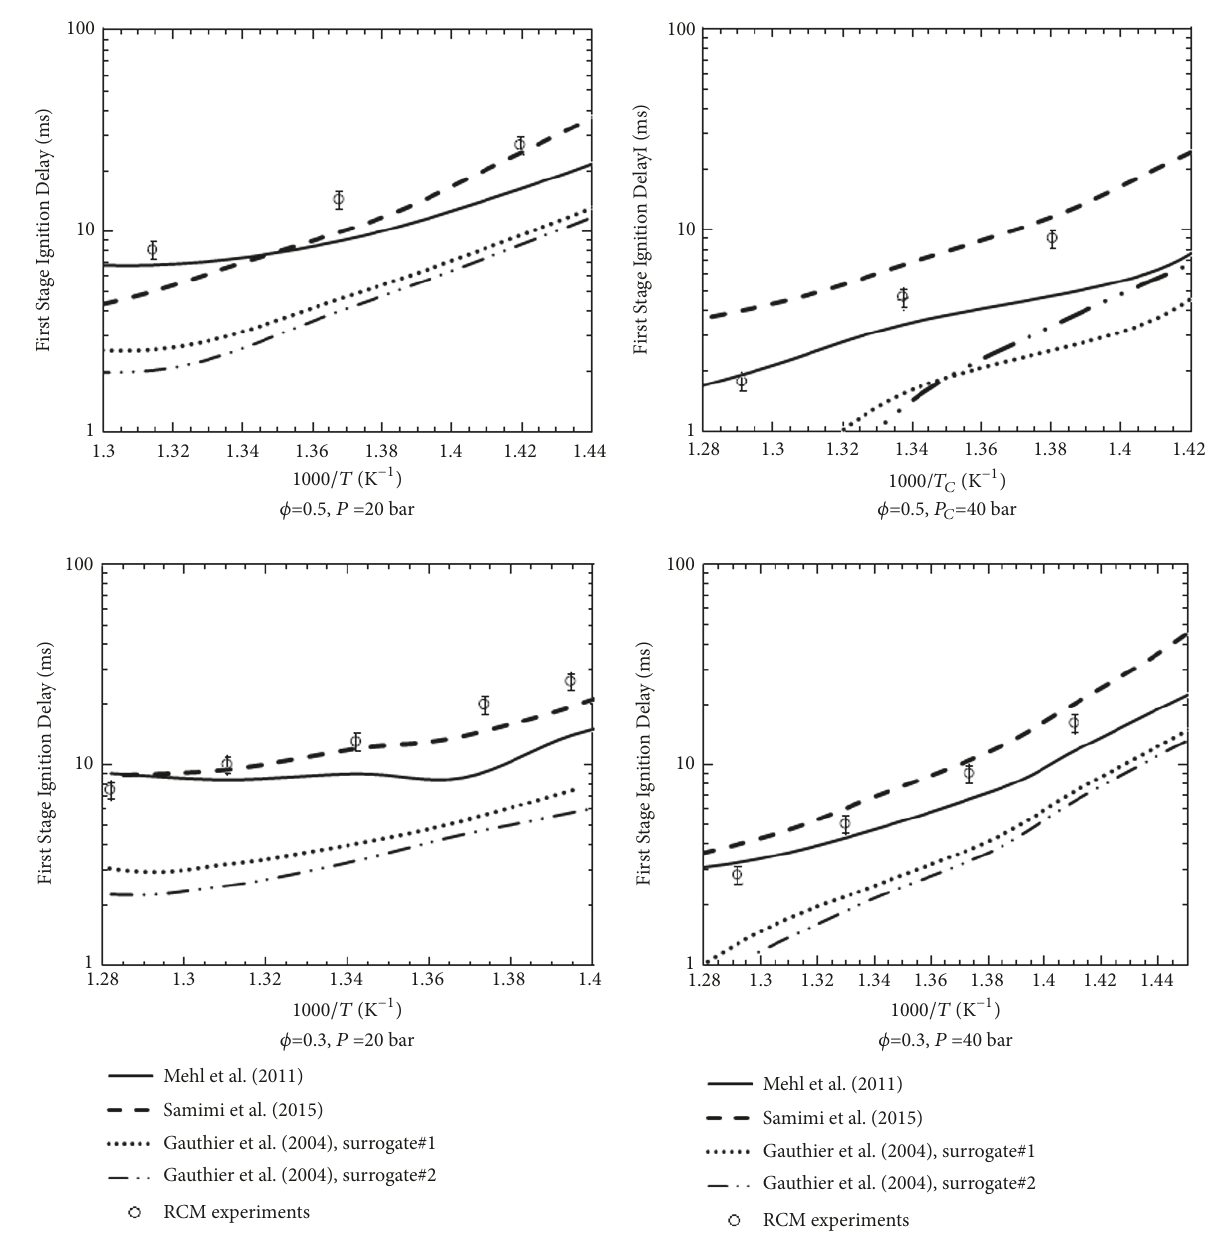
Figure 18: Comparison of experimental and simulated first-stage ignition delay times. Experimental data is from Kukkadapu et al. [23]. Surrogate simulations were carried out using Mehl et al. [13], Gauither et al. [10], and Samimi Abianeh et al. [19] surrogates using the mechanism of Samimi Abianeh et al.